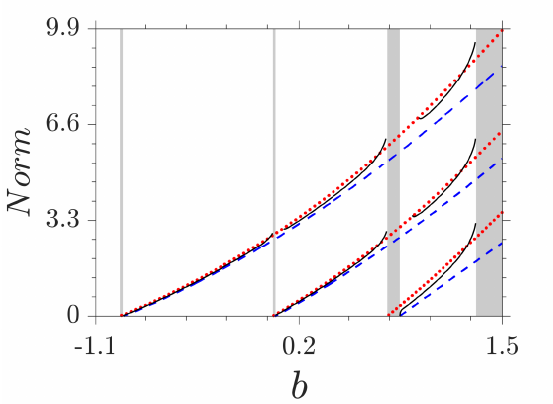
Figure 6. Norms of NLBWs and FGSs versus b . Dotted (red) and dashed (blue) lines represent NLBWs originating from the lower and upper edges of linear bands, respectively. Solid (black) lines stands for the norm of gap solitons.